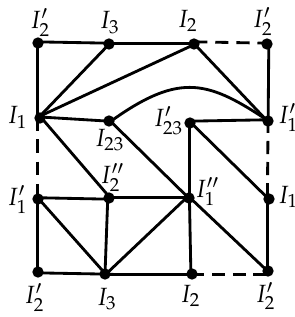
Figure 6. | Figure 6. |